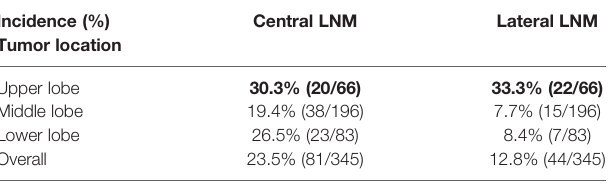
TABLE 4 | The incidence of central and lateral LNM in T1a PTC by tumor location. Incidence